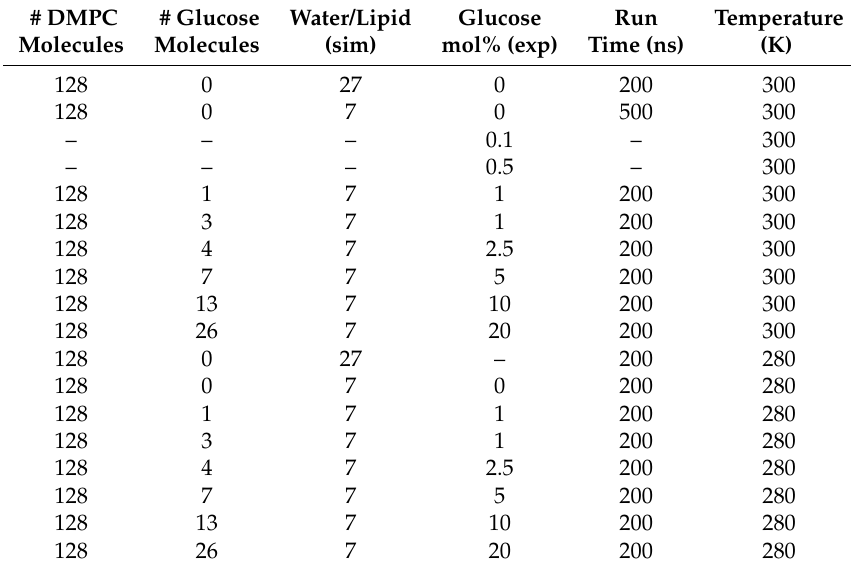
Table 1. Overview of the systems prepared for the MD simulations. All simulations were run for at least 200 ns, and the last 50 ns were used for analysis. The number of hydration water molecules was chosen to be 7 for the dehydrated systems, in accordance with experimental evidence, making the experimental and MD systems directly